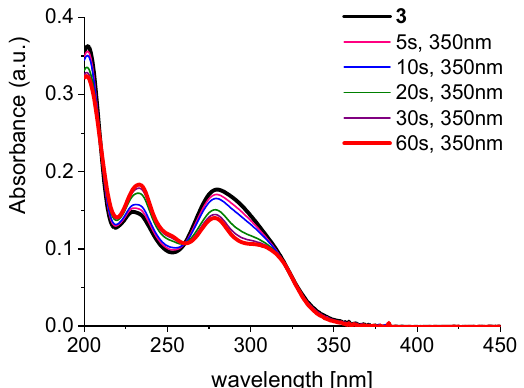
Figure 2. Irradiation at 350 nm of a 10 − 5 M solution of the α -methyl chalcone 3 in acetonitrile solutions. The photostationary equilibrium (E/Z = 35:65) is reached is less than 1 min. Negative photochromism is apparent from the bleaching of the 300 nm absorption and hyperchromic shift at 230